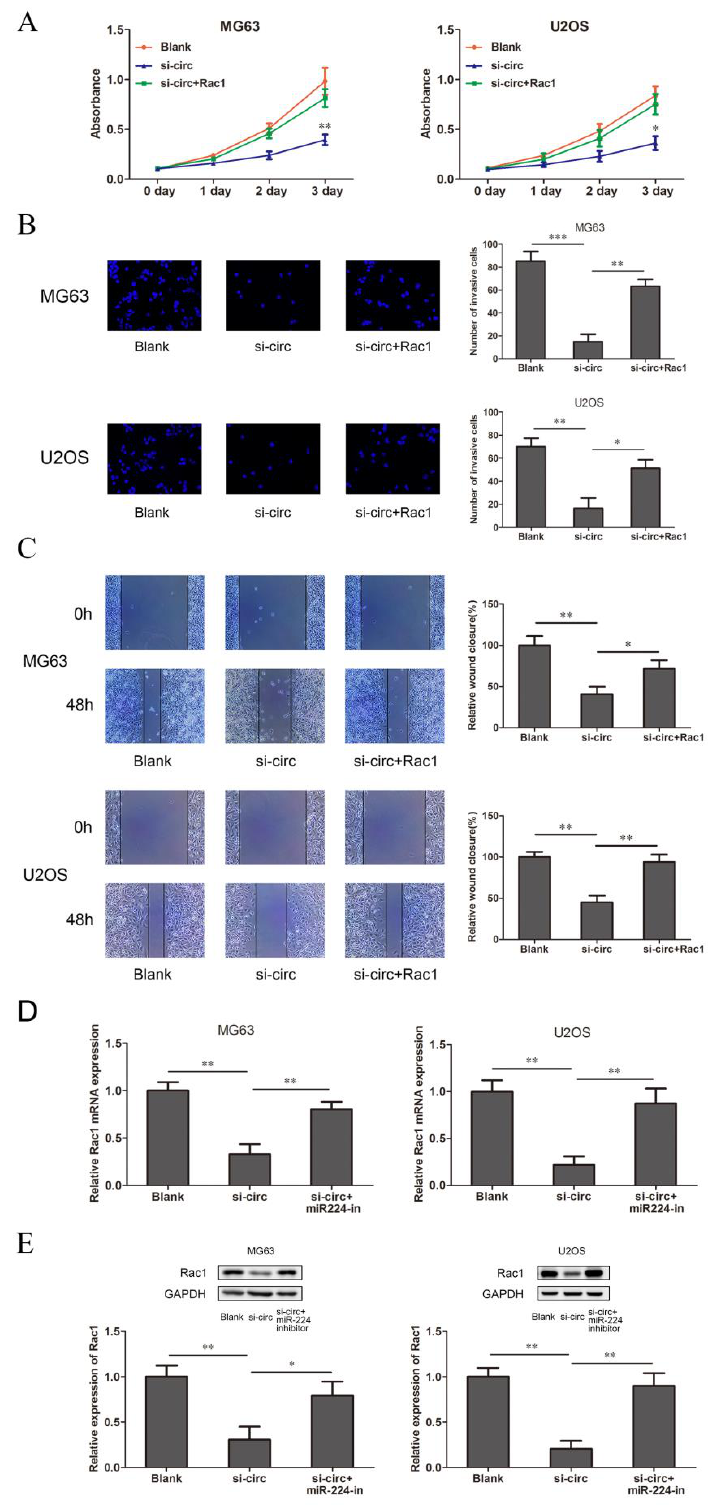
Figure 5. CircSRSF4 promotes OS cell proliferation, migration, and invasion through the circSRSF4/miR-224/Rac1 axis. ( A – C ) The proliferation activity, invasion, and migration ability of transfected cells were detected by CCK-8 assay, transwell assay, scratch wound healing assay in OS cells transfected with circSRSF4 siRNA, circSRSF4 siRNA + Rac1 respectively. ( D , E ) Relative mRNA and protein levels of Rac1 in OS cells transfected with circSRSF4 siRNA, circSRSF4 siRNA + miR-224 inhibitor by qRT-PCR and Western blotting, respectively. * p < 0.05, ** p < 0.01, *** p <